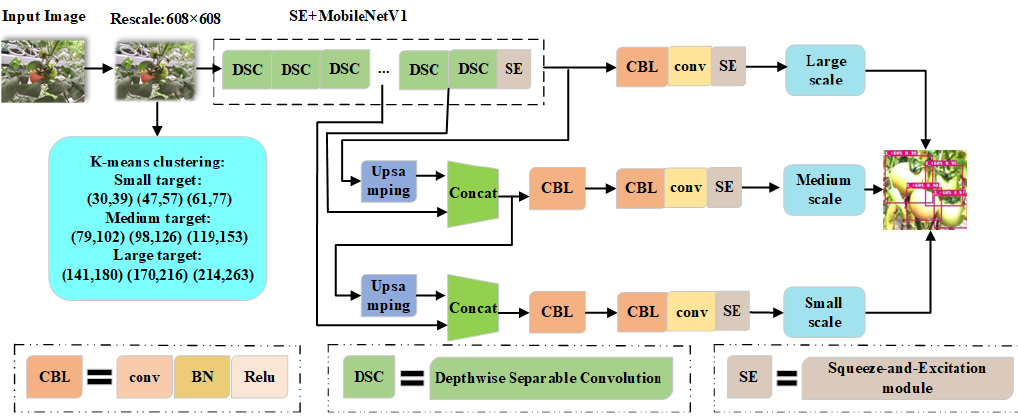
Figure 6. The structure diagram of SE-YOLOv3-MobileNetV1 network.